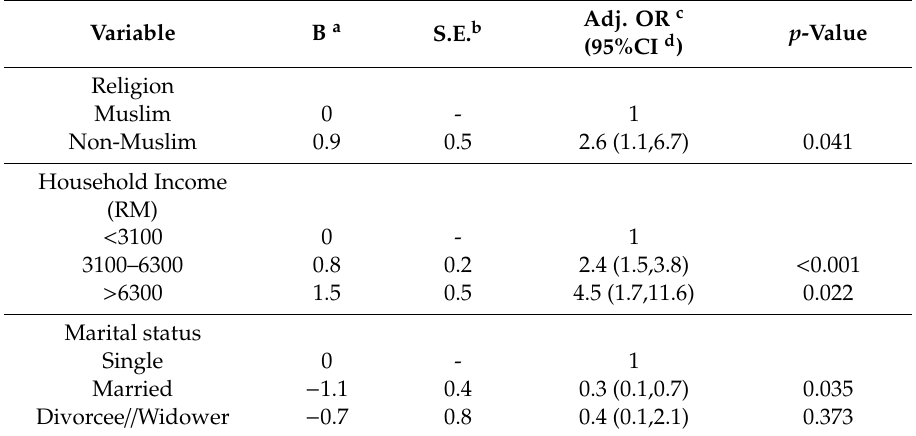
Table 3. Multiple logistic regression analysis for the association between sociodemographic characteristics and inappropriate TSB ( n = 381).